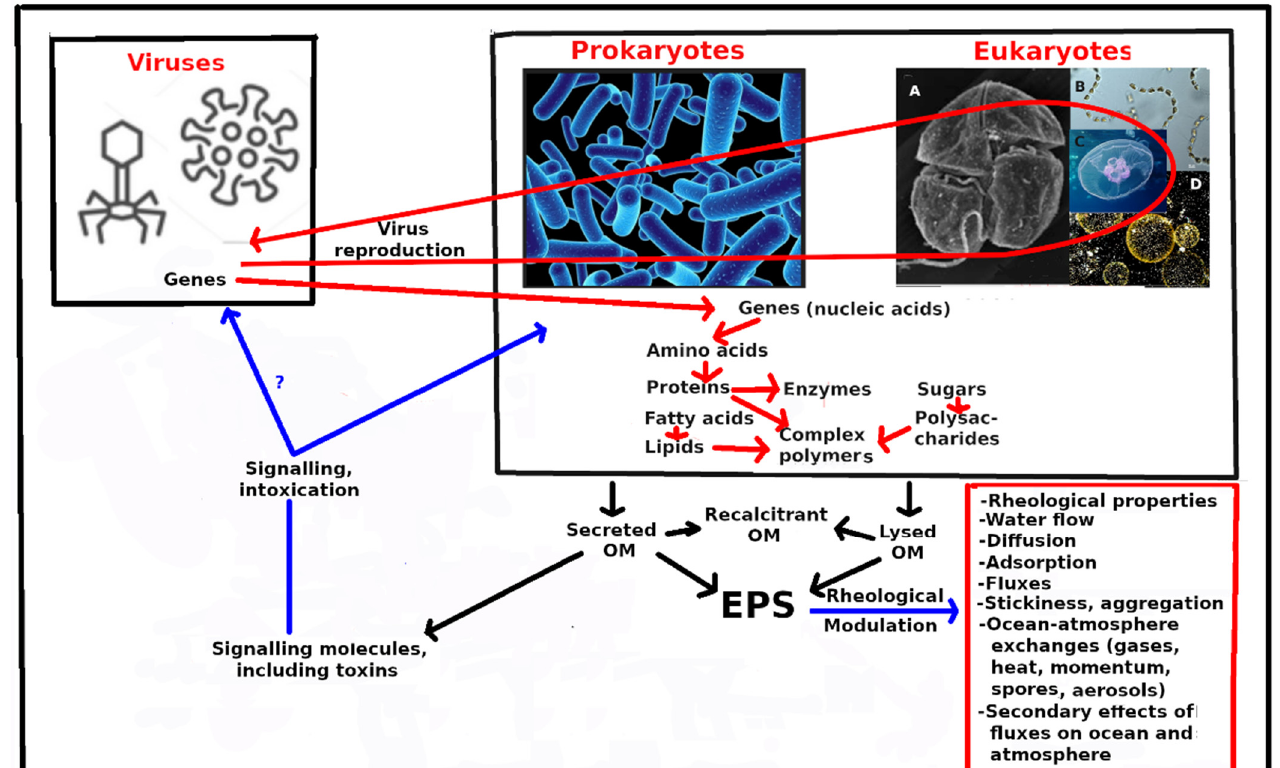
Figure 1. Three categories of gene-bearing (“living”) organisms are presented: viruses, prokaryotes and eukaryotes. Prokaryotes and eukaryotes are shown in the same compartment, as generally they both have an independent machinery to form amino acids and proteins (including enzymes) from “instructions” in their genes. Enzymes modulate (catalyze) intracellular molecular transformations (modulation pathways not shown). Viruses are placed in a separate box as they need to introduce their genes into prokaryotic or eukaryotic cells, taking some control of these cells in order to reproduce their genes and outer casing. Red arrows represent the pathways of viral reproduction and transfer of viral genes to replace or modulate prokaryotic or eukaryotic genes [16]. Red arrows are used also to represent transfers between the major types of organic molecules inside cells. Black arrows represent transformations between the major suggested extracellular pools of organic matter (OM). Blue arrows represent modulation by extracellular polymeric substances (EPS) on physical and physicochemical processes in the ocean and at the ocean–atmosphere interface, as well as secondary effects in the ocean and the atmosphere (inside red box). Blue arrows also represent signaling and intoxication pathways by signaling molecules and toxins, respectively. Eukaryotic plankton is represented by A—a dinoflagellate; B—a diatom; C—a jellyfish medusa; D—a raphidophyte. This is not a sketch of trophic or energy pathways.